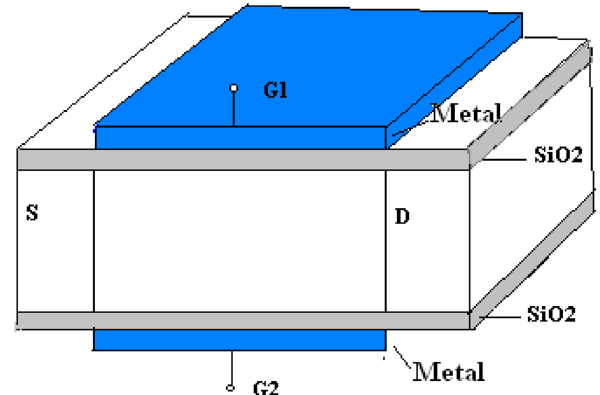
Fig. 2 The planar structure of Double-Gate MOSFET (S: Source, D: Drain, G1 and G2: Gate-1 and gate-2, SiO